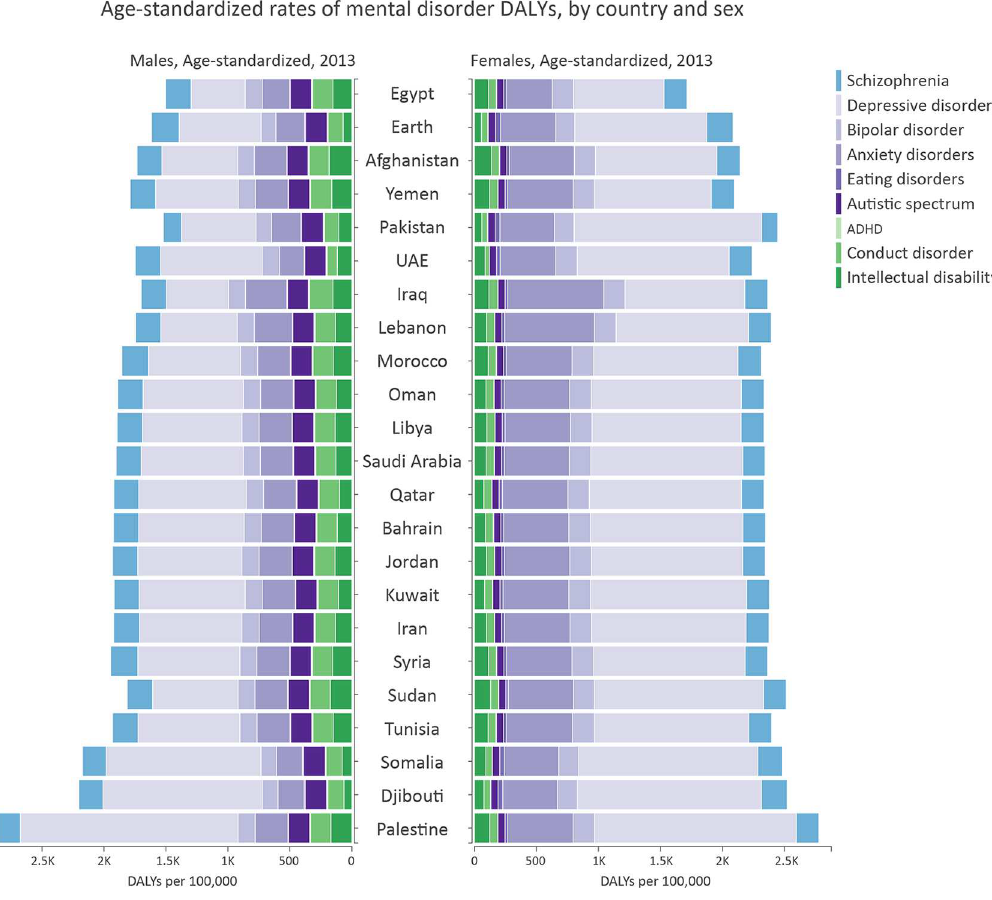
Fig 7. Age-standardized rates of mental disorder DALYs, by country and